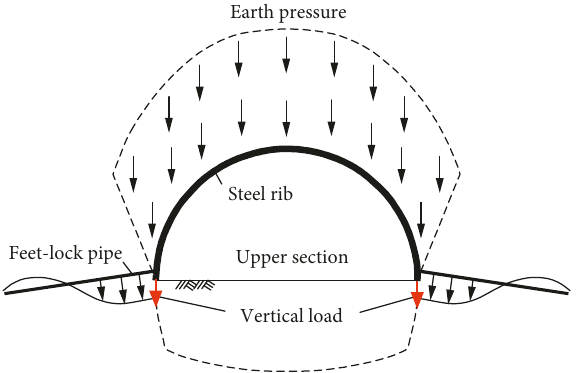
Figure 2: Steel ribs with the support of the feet-lock